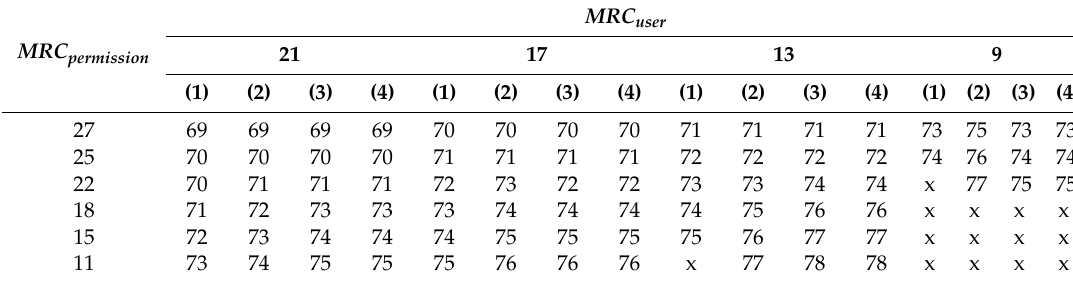
Table 21. The number of optimized roles in Firewall1.